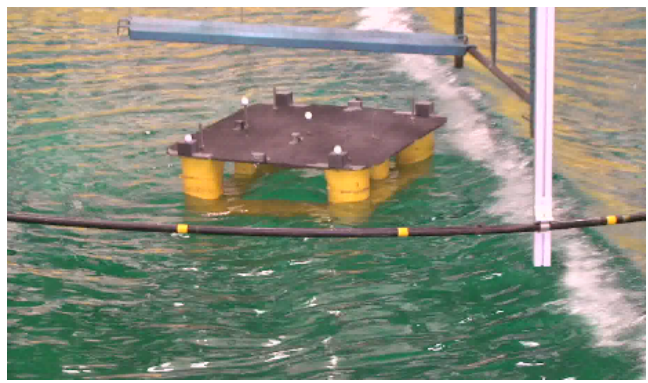
Figure 2. Picture of the model-scale semisubmersible platform during the tests carried out at the wave basin at Universidade de São Paulo